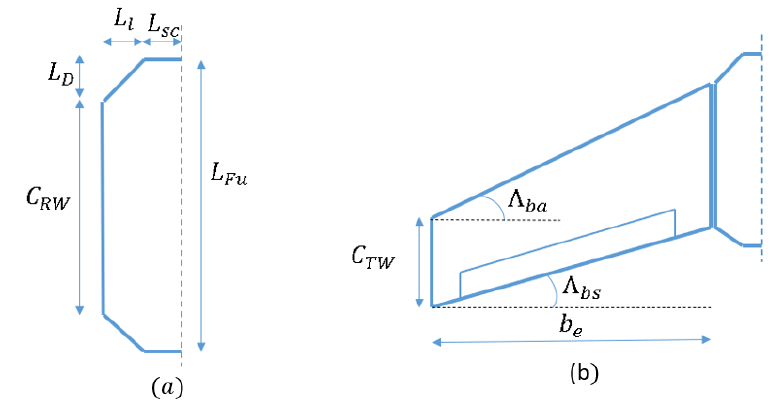
Figure 3. Fuselage scheme: ( a ) Half fuselage isolated, ( b ) Fusselaje and wing assembly.